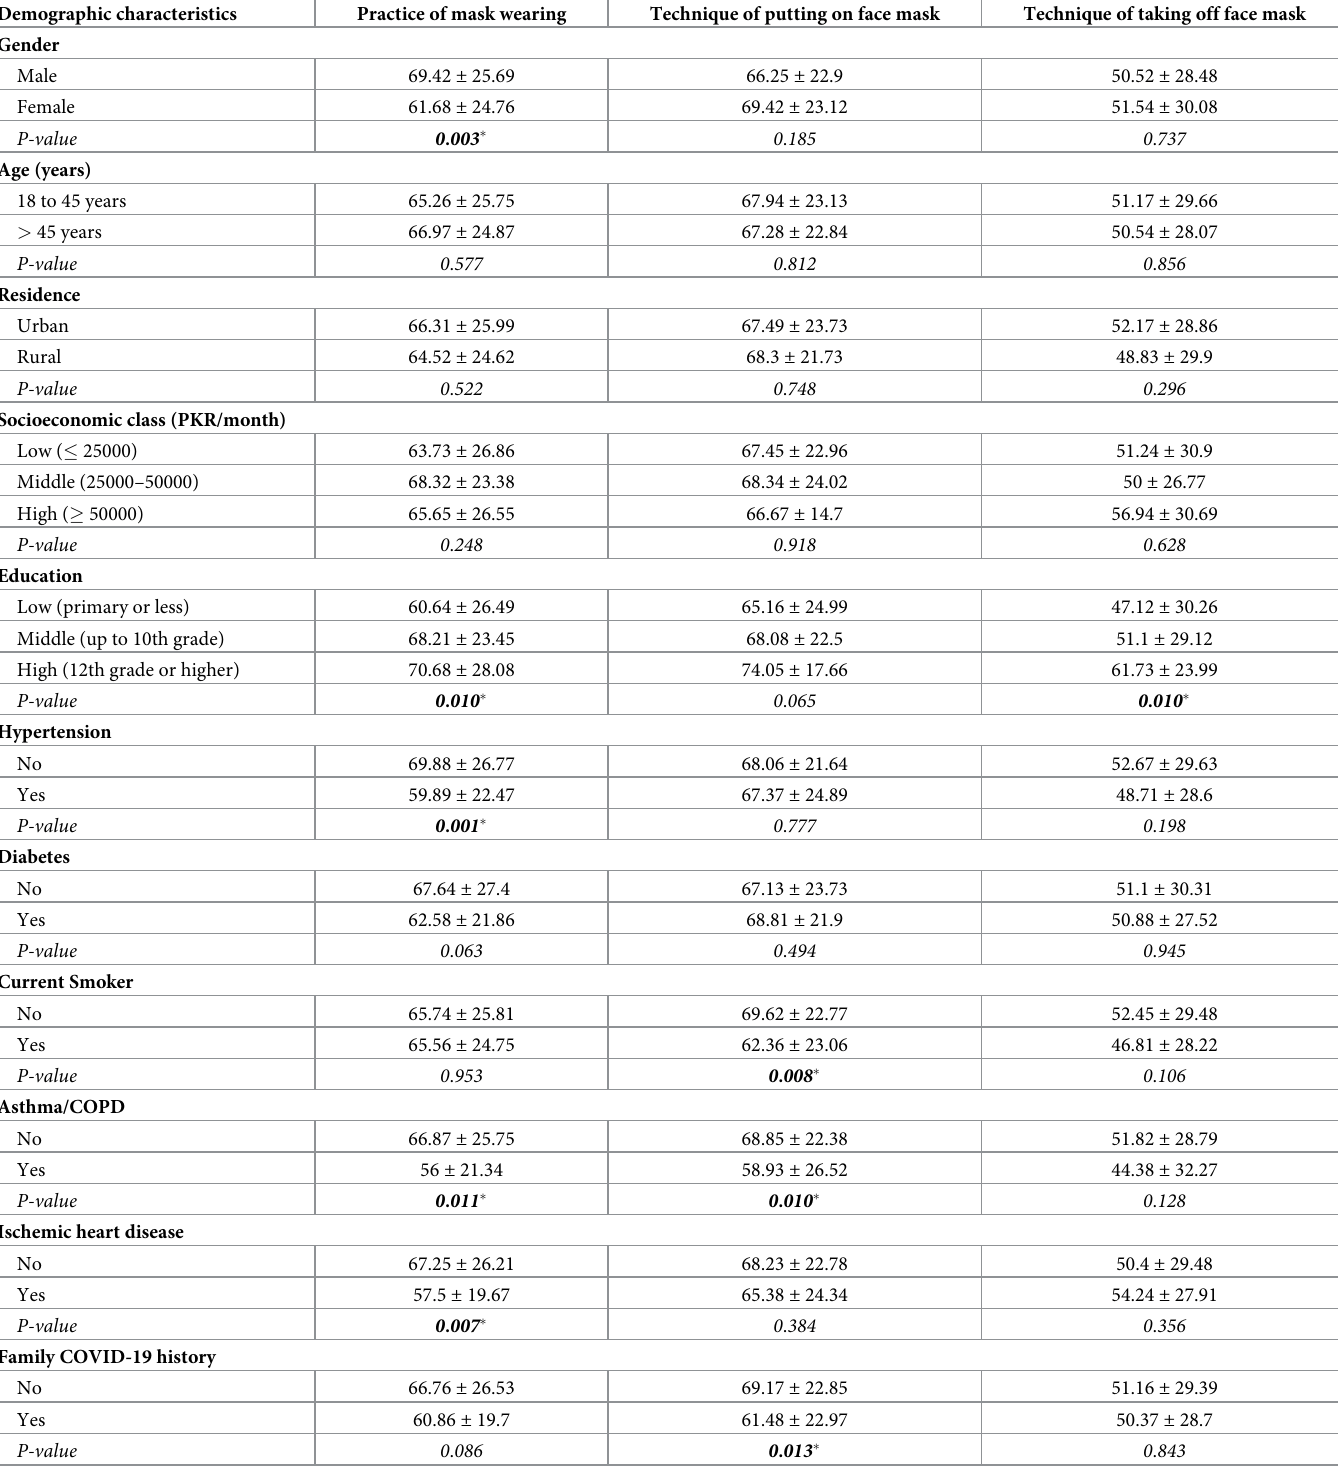
Table 2. Mean percentage score of practice of mask wearing and technique of putting on and taking off face mask by various demographic and baseline